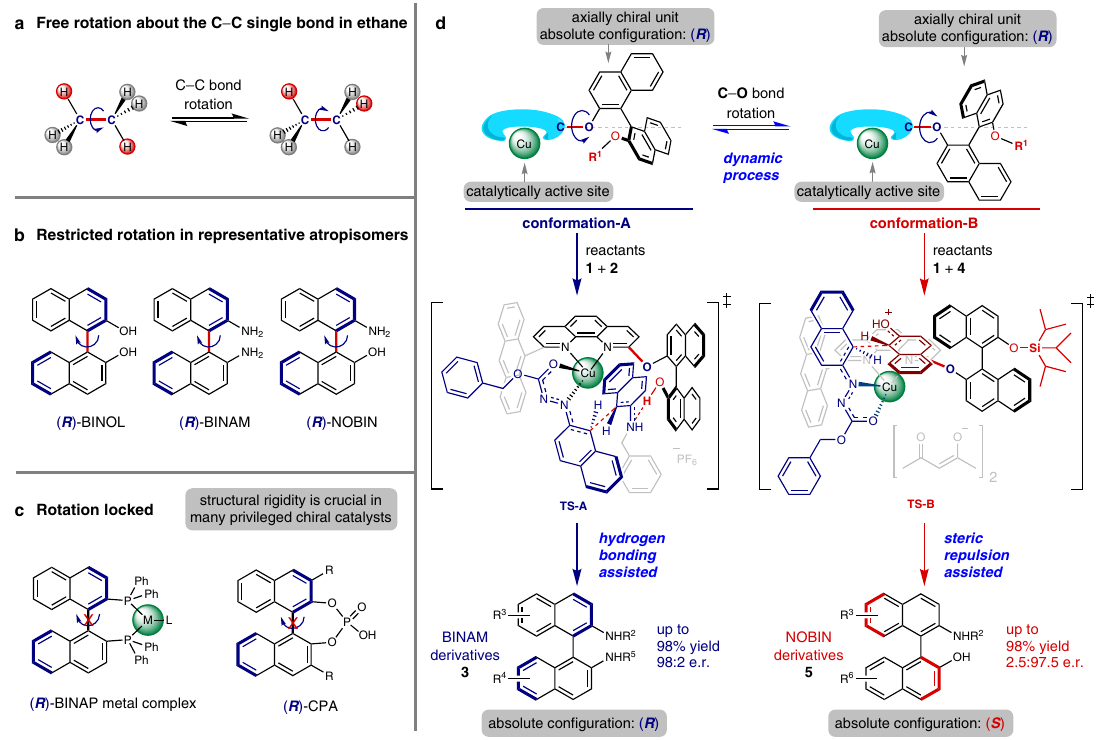
Fig. 1 | Rotations about single bonds and conformational enantiodiscrimina- tion. a C – C bond rotation in ethane. b Restricted rotation about the C – C single bonds in atropisomers. c Rotation about the C – C single bond locked in BINAP- metal complexes and BINOL-based phosphoric acids. d Design of a chiral catalytic system for conformational enantiodiscrimination enabling asymmetric